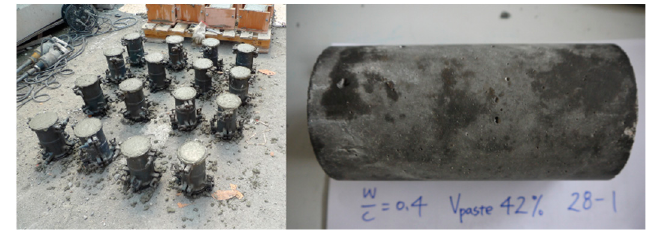
Figure 1. Cylindrical concrete specimens.